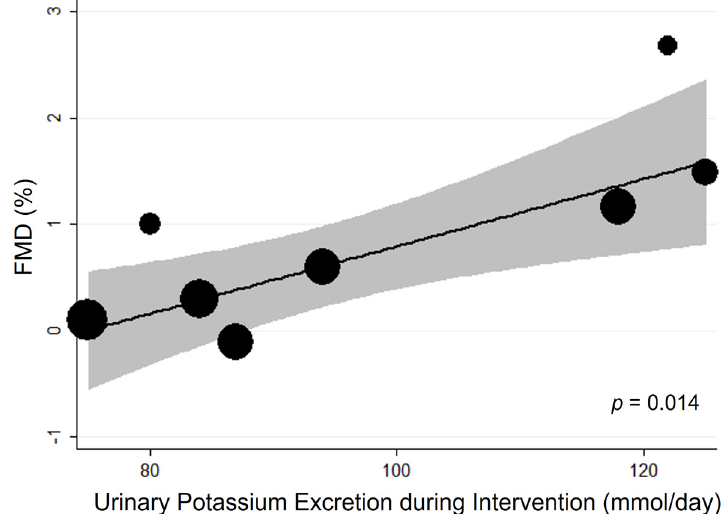
Figure 2. Bubble plot for random-effects meta-regression of mean difference (MD) in flow-mediated dilation (FMD) by potassium supplementation of the single studies. Bubbles each represent one study and are plotted according to the study’s MD and urinary potassium excretion of the single study; bubble sizes reflect the relative weight apportioned to studies in the random-effects meta-regression; the solid line indicates the line of best fit. Potassium supplementation is represented by urinary potassium excretion (mmol/day).